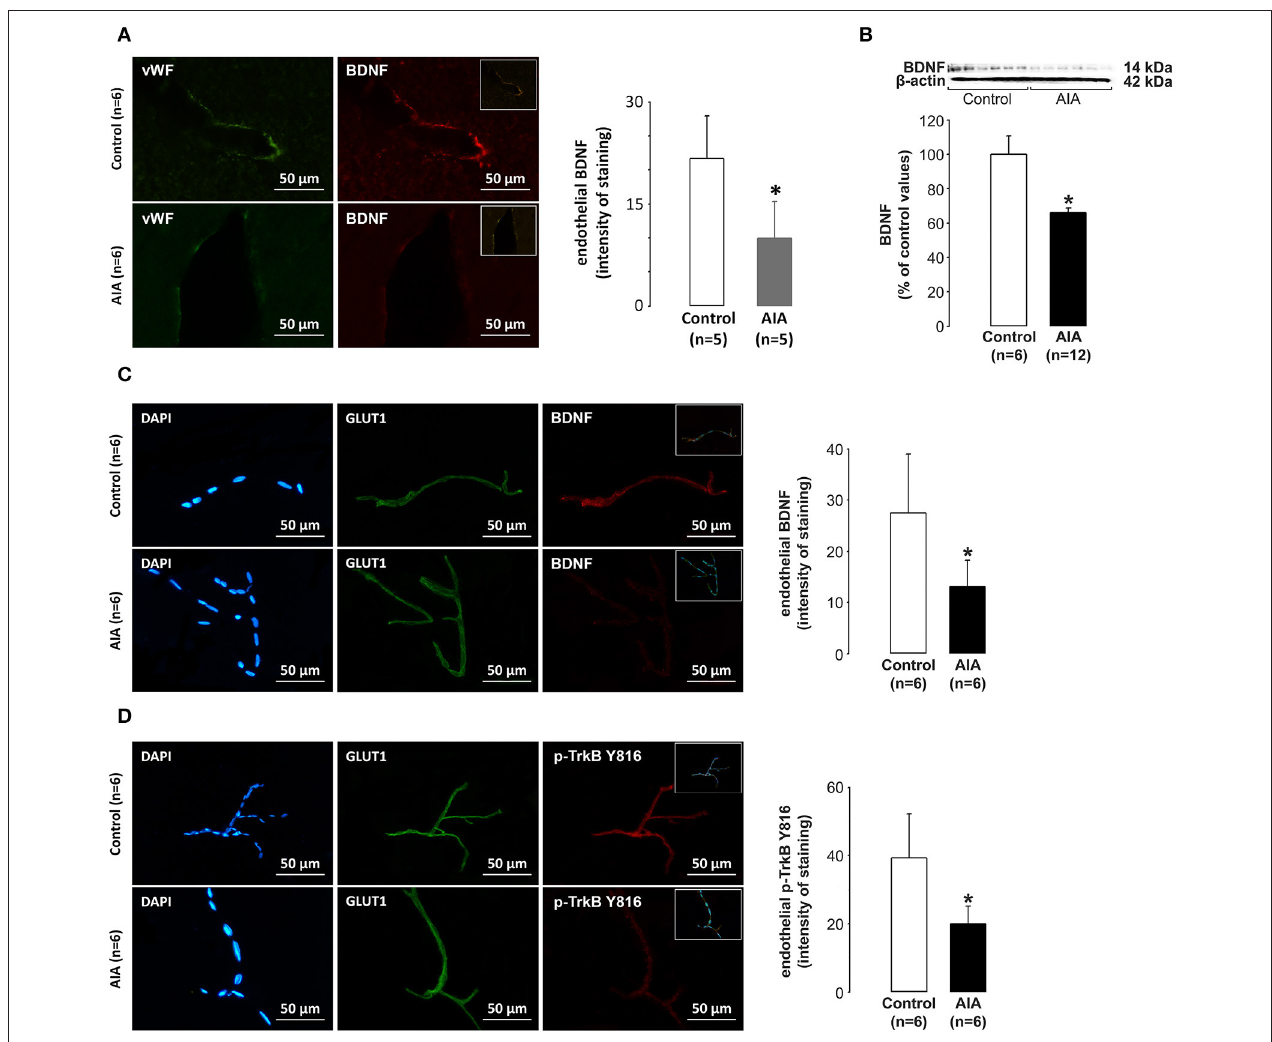
FIGURE 2 | (A) Effect of AIA on endothelial BDNF expression using immunohistochemical analysis of brain slices. Representative photograph of vWF (a marker of endothelial cells, green), BDNF (red) labeling and merged images (insert) in hippocampal arterioles and quantification of endothelial staining intensity, (B) Effect of AIA on BDNF levels in cerebral microvessels-enriched fractions. A representative immunoblot of BDNF and β -actin as internal control is shown above the bar graphs, (C) Effect of AIA on endothelial BDNF expression using immunohistochemical analysis of cerebral microvessels-enriched fractions. Representative photographs of DAPI (a nuclear marker, blue), GLUT1 (a marker of endothelial cells, green) BDNF (red) immunostaining and merged images (inserts) and quantification of staining intensity, (D) Effect of AIA on endothelial p-TrkB Y816 receptors expression (see legend C ). Brain and vascular samples were collected at day 31 ± 2 post-immunization. Values are expressed as means ± SD, n = number of rats, * p < 0.05 vs. control